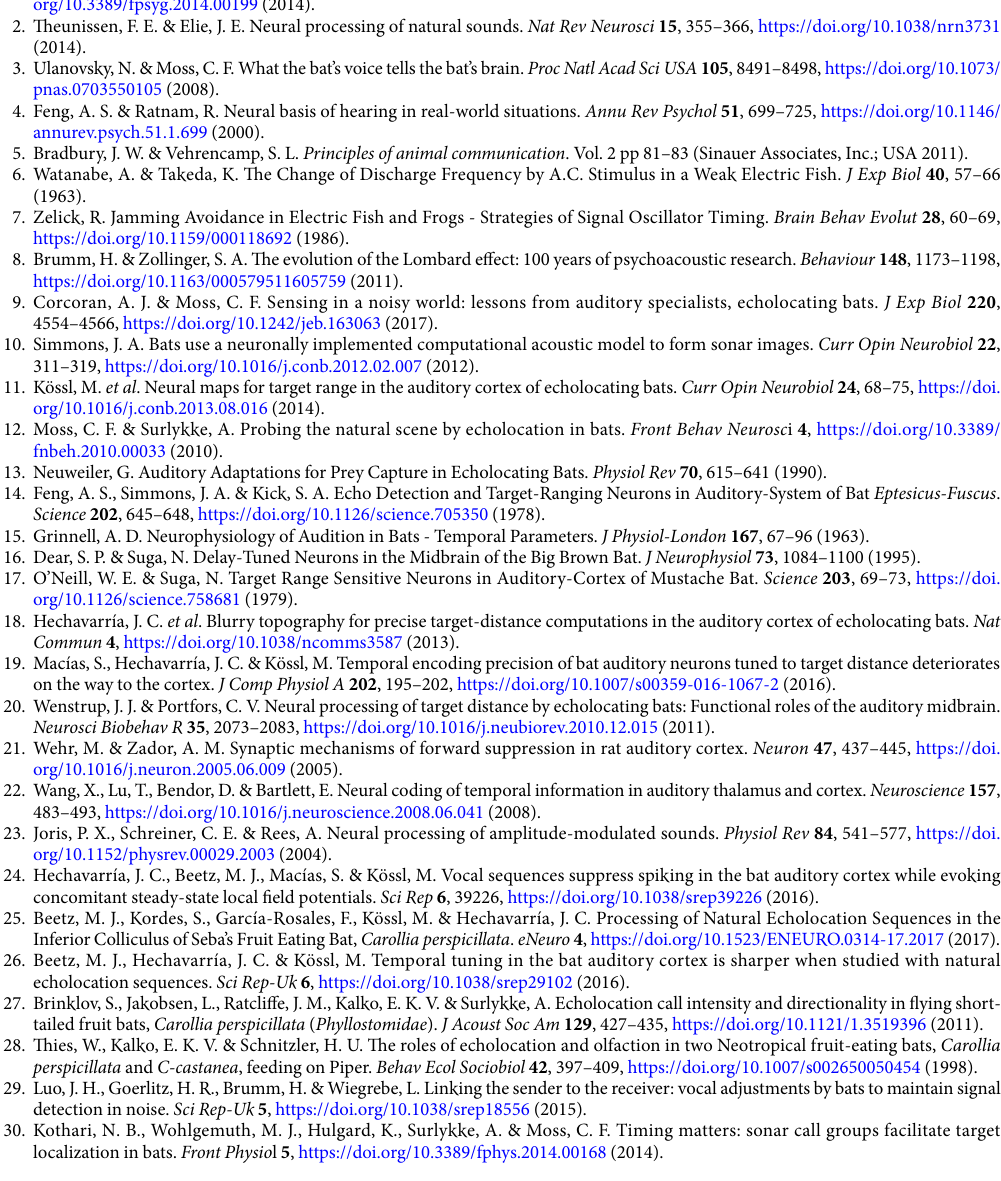
In the equation (1), mix i and m i represent the median spike rate in response to the call-echo element in the mix- ture and masker situation, respectively. Thus, high spike rate differences between the response to the mixture and masker result in high d ′ values. These differences are due to the presence of the target in the mixture and may either arise from responses to the target or from an integration of the target and masker stimulus. A neuronal response arising from stimulus integration represents a neuronal correlate of jamming. To determine the target detection in the mixture situation it is necessary to exclude high d ′ values arising from jamming. Therefore, we calculated a cumulative d’ for each unit by considering only d ′ values from call-echo elements that elicited a neuronal response in response to the target stimulus i . Cumulative d ′ values were calculated according to the following equation (2):